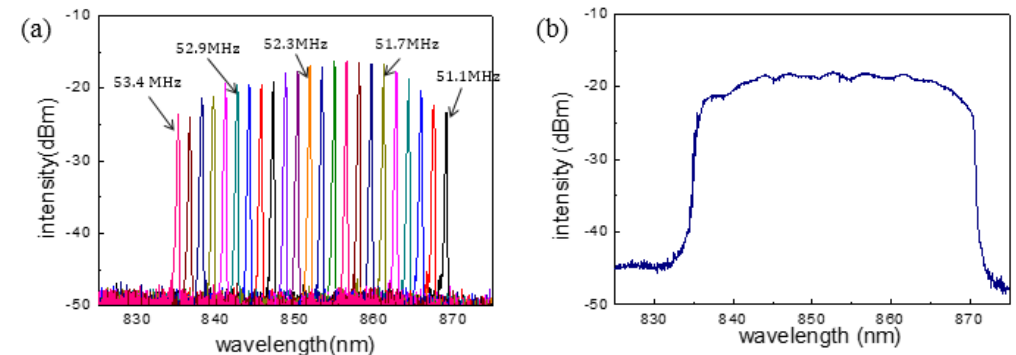
Figure 2. ( a ) Static output spectra of electro-optic swept source based on an acousto-optic tunable filter (AOTF); and ( b ) the peak hold mode spectrum of the dynamic sweeping output.